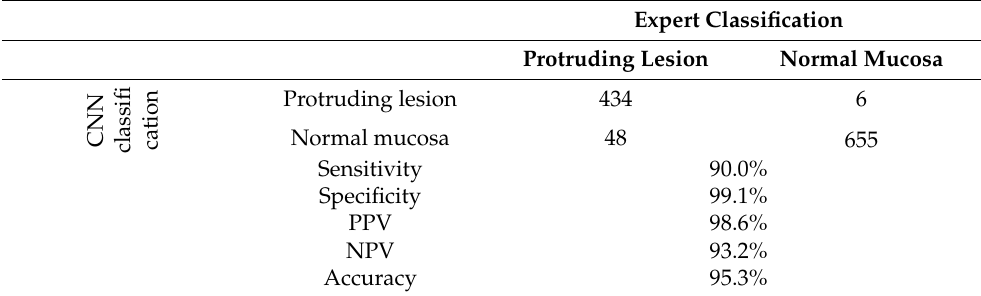
Table 1. Confusion matrix and performance marks .